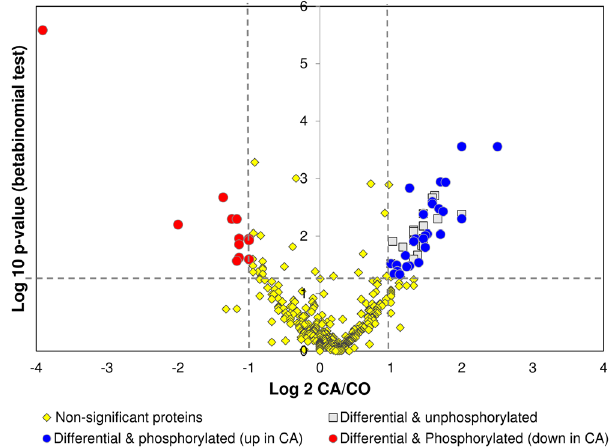
Figure 6. Volcano plot constructed from weighed spectral counts. The plot shows how much and how significant the identified proteins were differentially abundant between CA and CO flies. Horizontal dotted line depicts a p < 0.05 cutoff and vertical dotted lines depict 2- and 0.5-fold cutoffs. Among 64 significant differential proteins (i.e. above cutoff values), 18 were identified without phosphorylated peptides (grey squares), 12 were phosphorylated and less abundant in the CA samples (red circles) and 34 were phosphorylated and more abundant in the CA samples (blue